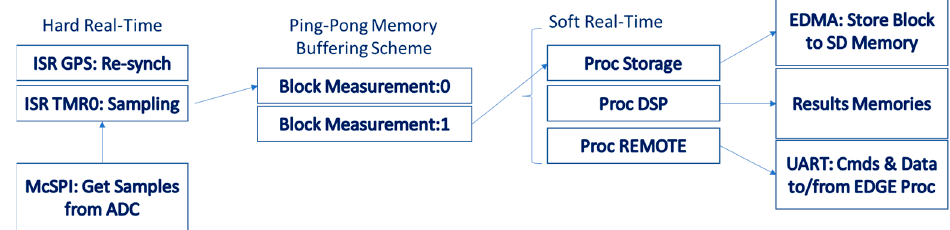
Figure 4. DSP module fi rmware key functionalities.